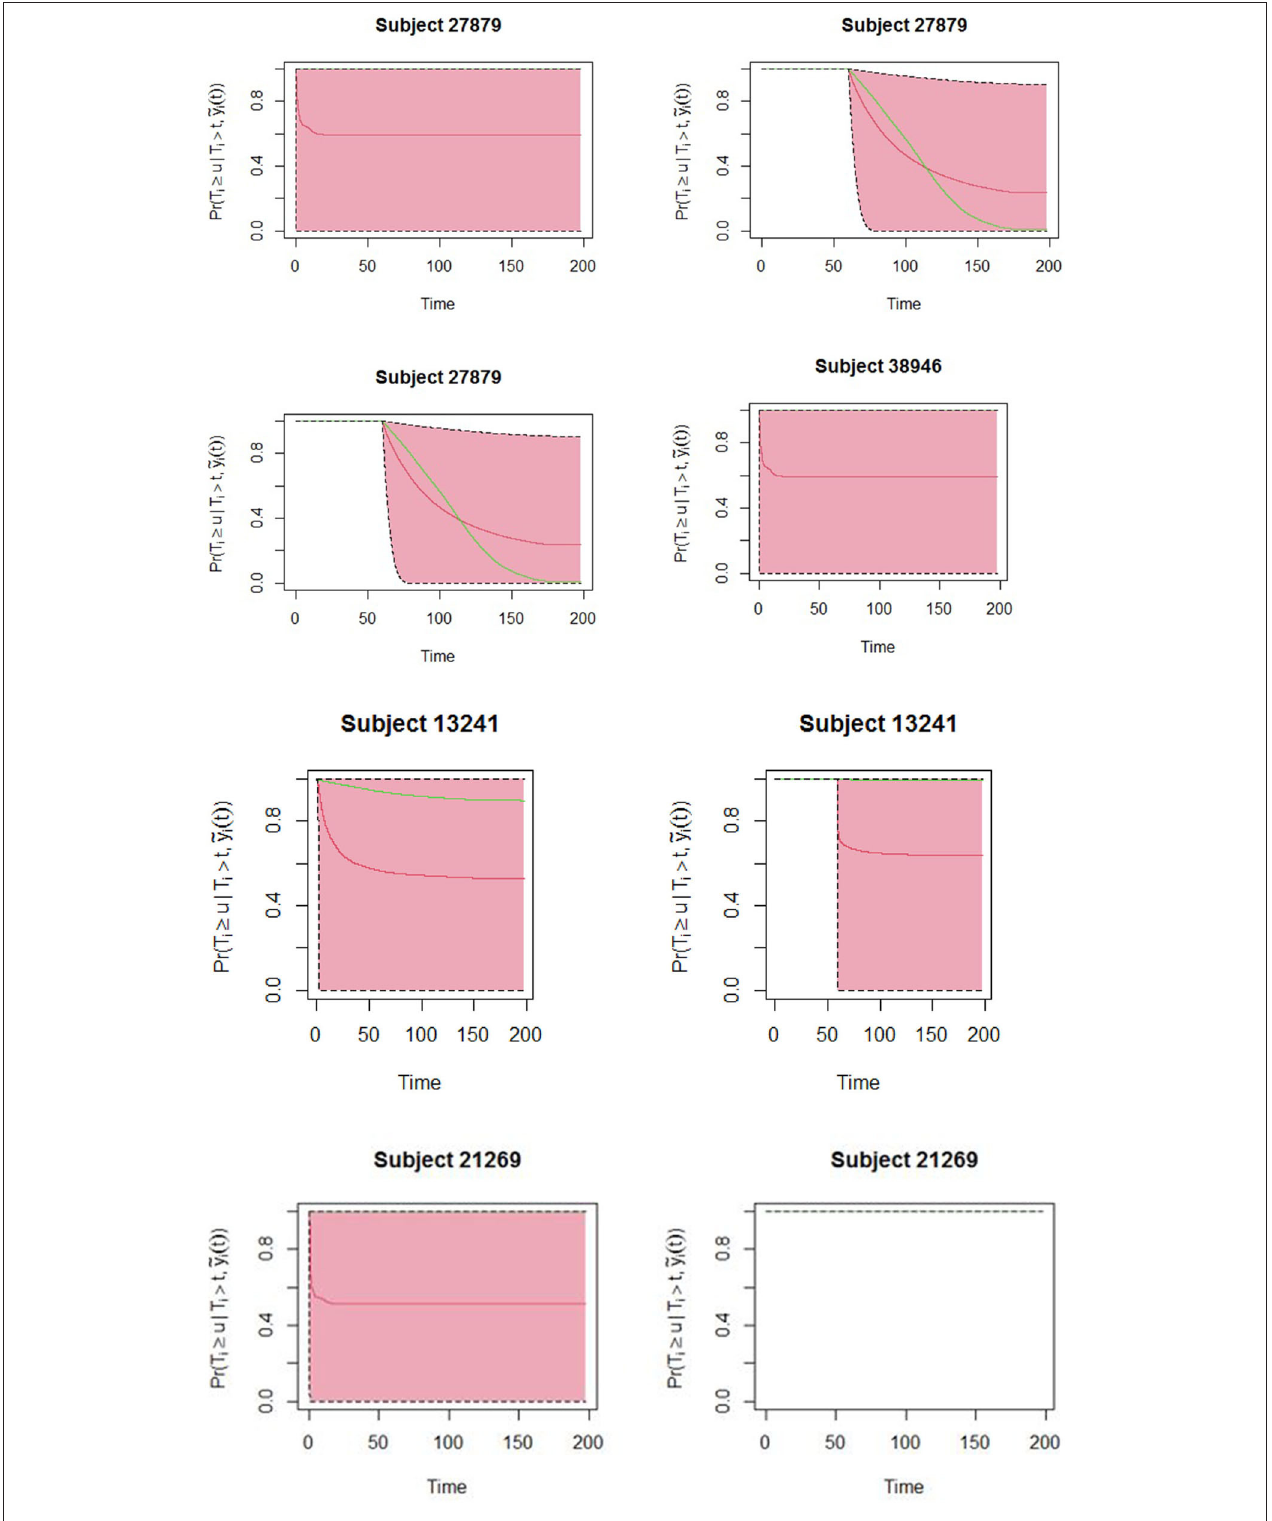
FIGURE 3 | Dynamic predictions for patients 27879, 38946, 21269, and 13241. Solid red line is the mean of 2,000 MCMC samples. The green line is the true observed survival probabilities. Dashed lines are the 2.5 and 97.5% percentiles range of the 2,000 MCMC samples.